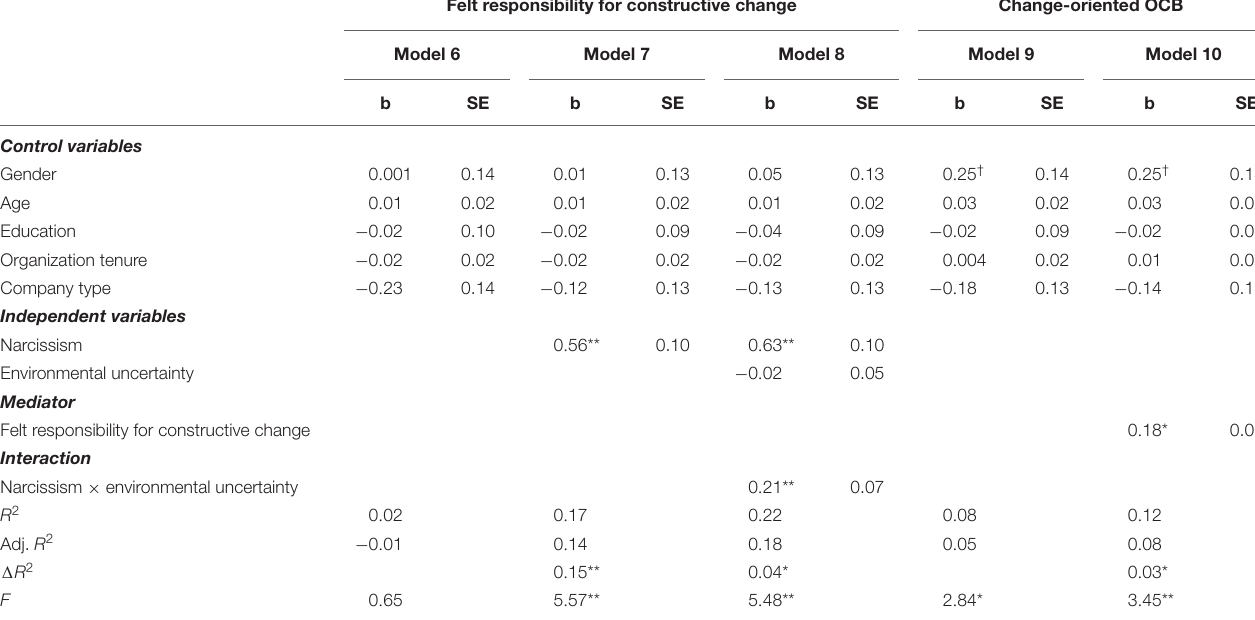
TABLE 6 | Study 2 regression